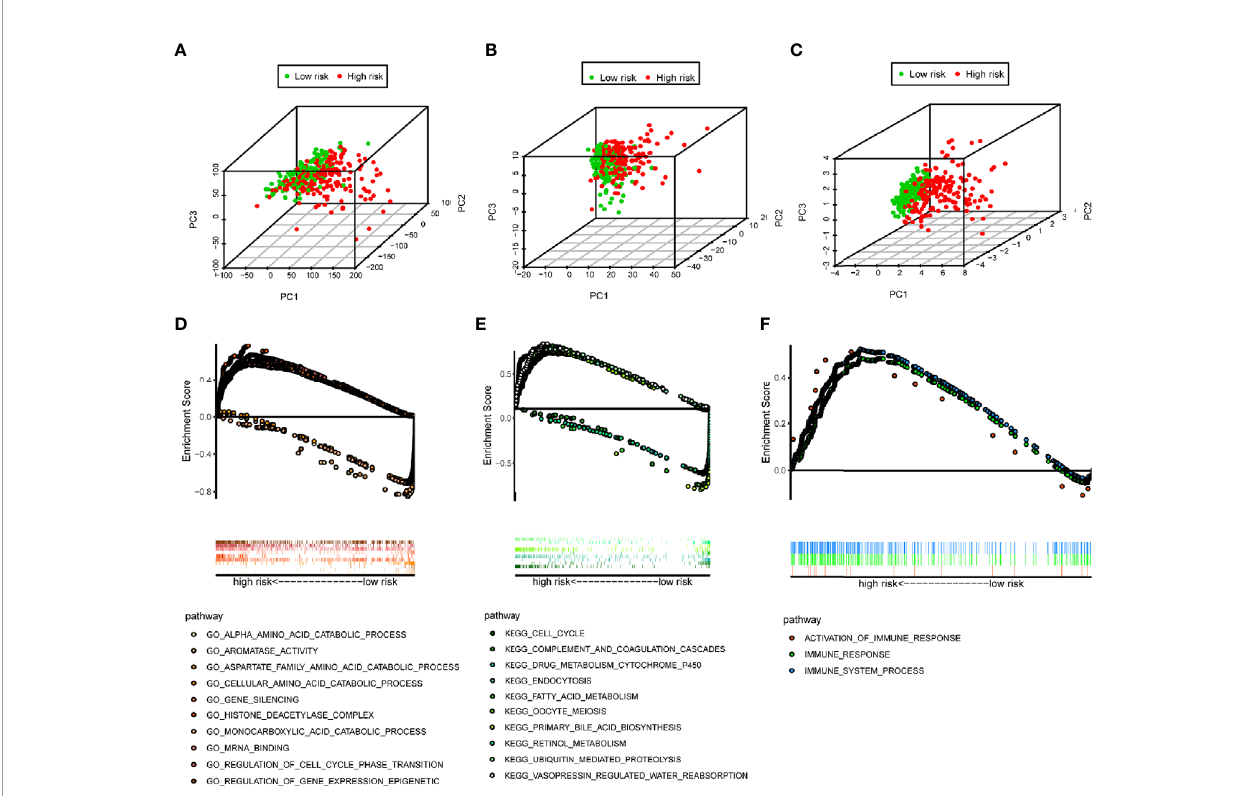
FIGURE 5 | PCA analysis and GSEA analysis. (A – C) The results demonstrated that in the six immune-related lncRNAs set, the low-risk group and the high-risk group were separated into two parts better than based on all genes set, all immune-related lncRNAs set. (D) GO analysis and (E) KEGG analysis results. (F) Immune-related responses such as activation of immune response, immune response and immune system process were enriched in high-risk